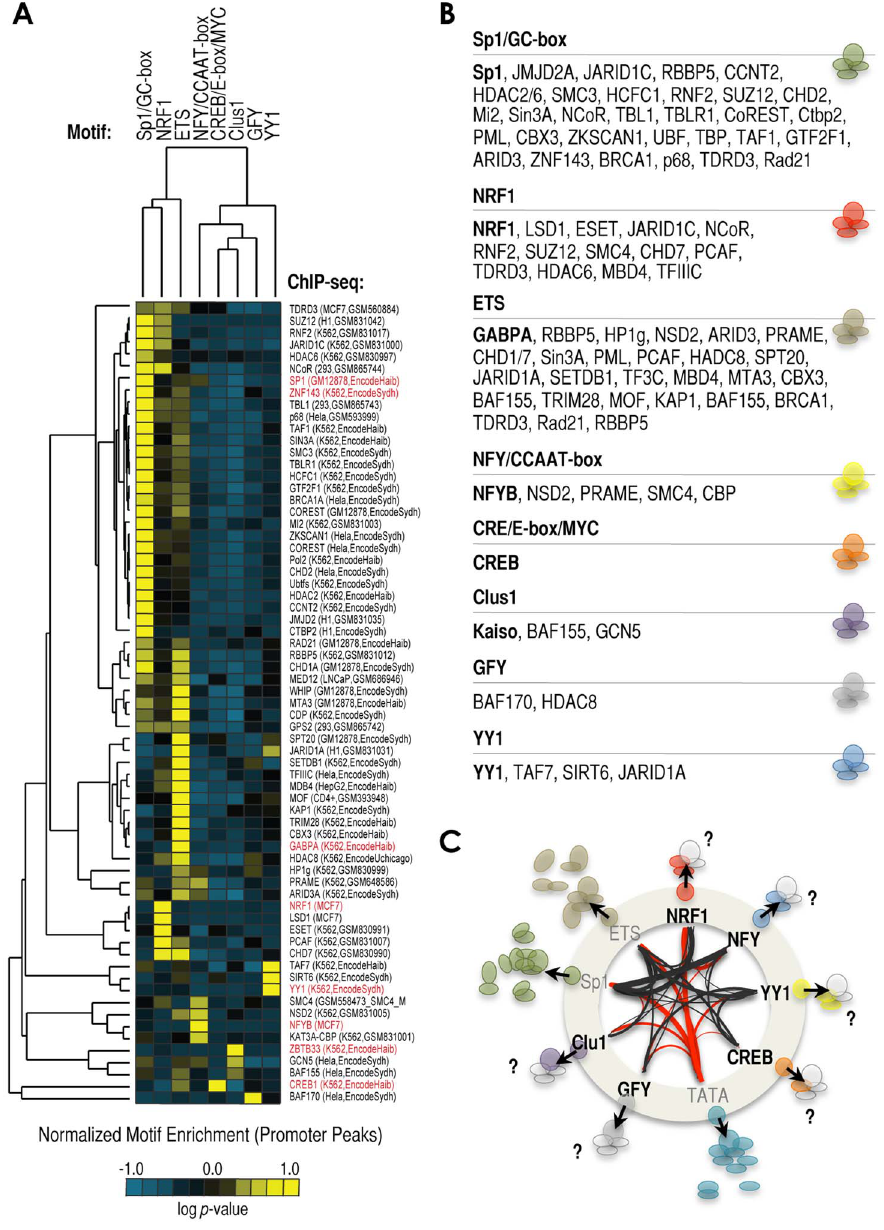
Figure 5. Signature of cofactors associated with the enrichment of a specific cardinal motif. ( A ) Heatmap analysis of relative enrichment of cardinal motifs in proximal promoter regions occupied by different proteins, based on . 60 ChIP-seq datasets: n=8 TF ChIP-seq datasets (labeled in red) and n=59 cofactors/others ChIP-seq datasets (labeled in black). Sources of ChIP-seq experiments: ENCODE (accession number and/or laboratory are included in parenthesis); and NRF1, NFYB, and LSD1 datasets were generated in this study. The vector of motif enrichment for each experiment was normalized and centered on the mean value to reveal the preferences of each experiment for cardinal motifs. The analysis shows negative log of the hypergeometric p -value. ( B ) List of cofactors associated with each cardinal motif, based on ( A ). ( C ) Model of signatures of cofactors associated with the presence of a specific cardinal motif (see text for details).